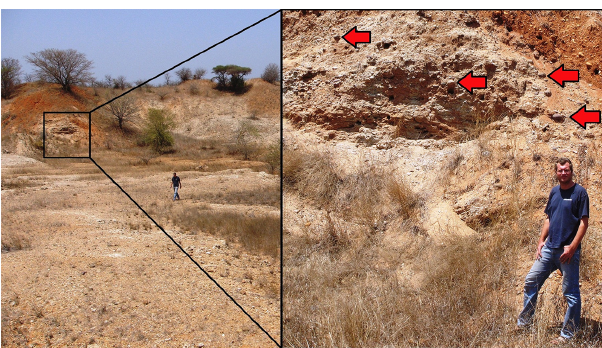
Figure 15. Round boulder deposit at a quarry close to the Olifants River’s confluence (photographer: De Dapper, 2009).